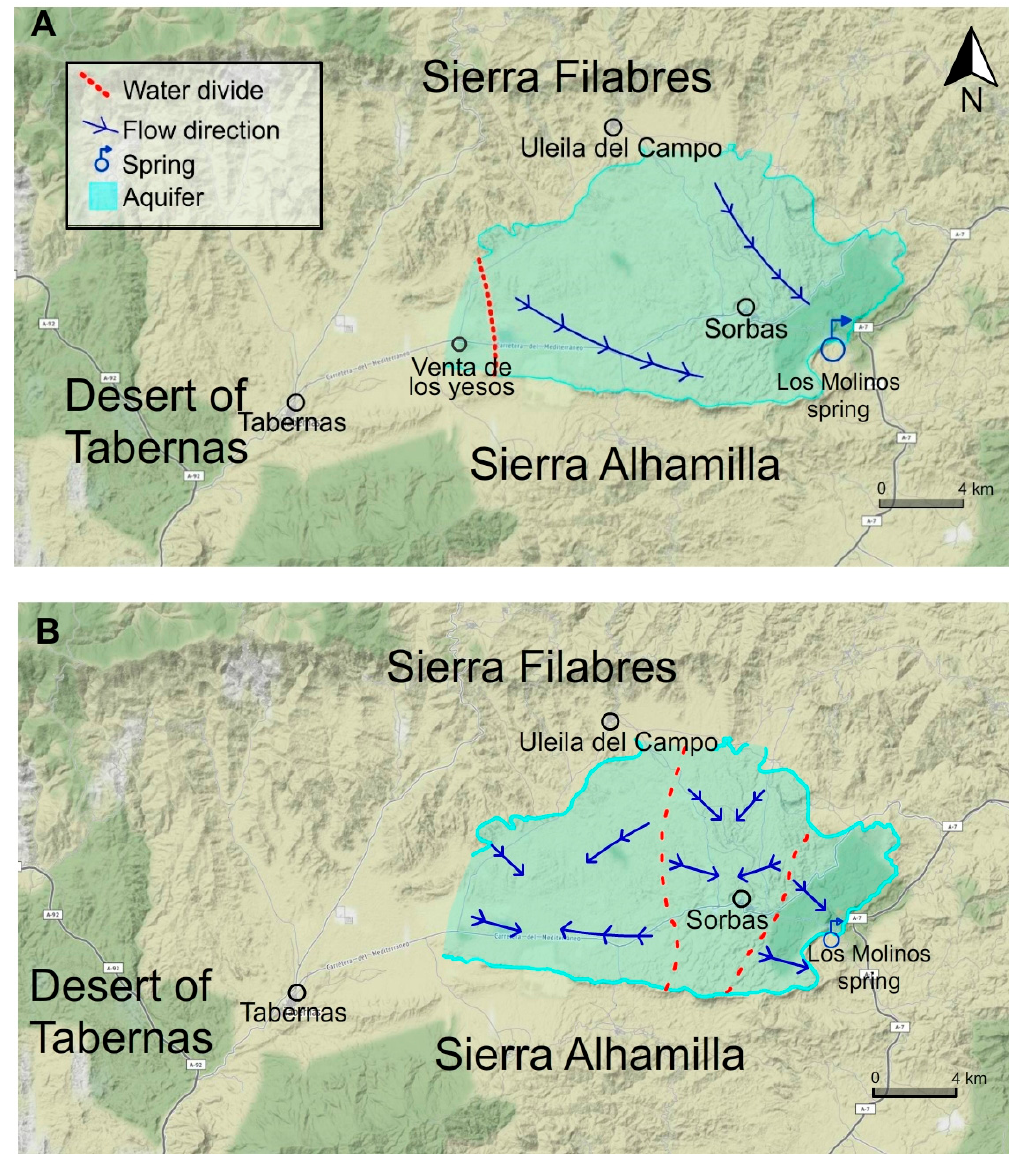
Figure 5. ( A ) Map of the surface of the “Alto Aguas” aquifer. Natural groundwater flow to the “Los Molinos” spring. The red dotted line is the water divider, the blue indicates flow lines and spring. ( B ) Groundwater flow is modified by extractions for intensive irrigation of crops, reducing contributions to the Los Molinos spring.